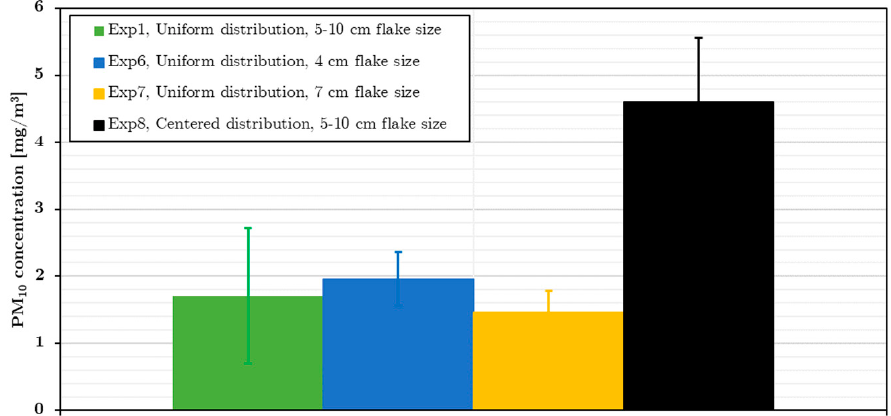
Figure 7. Average PM 10 concentration in the chimney for the supplementary experiments.